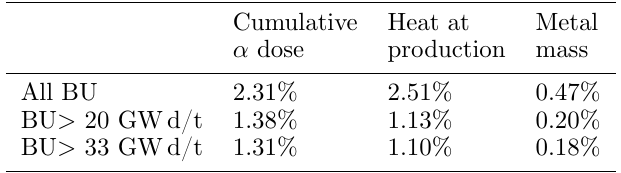
Table 4. Criterion prediction for the 3 limits considered for canister production regarding the burn-up of the MOX or MIX spent fuels coming from the independent database built for neural network testing.